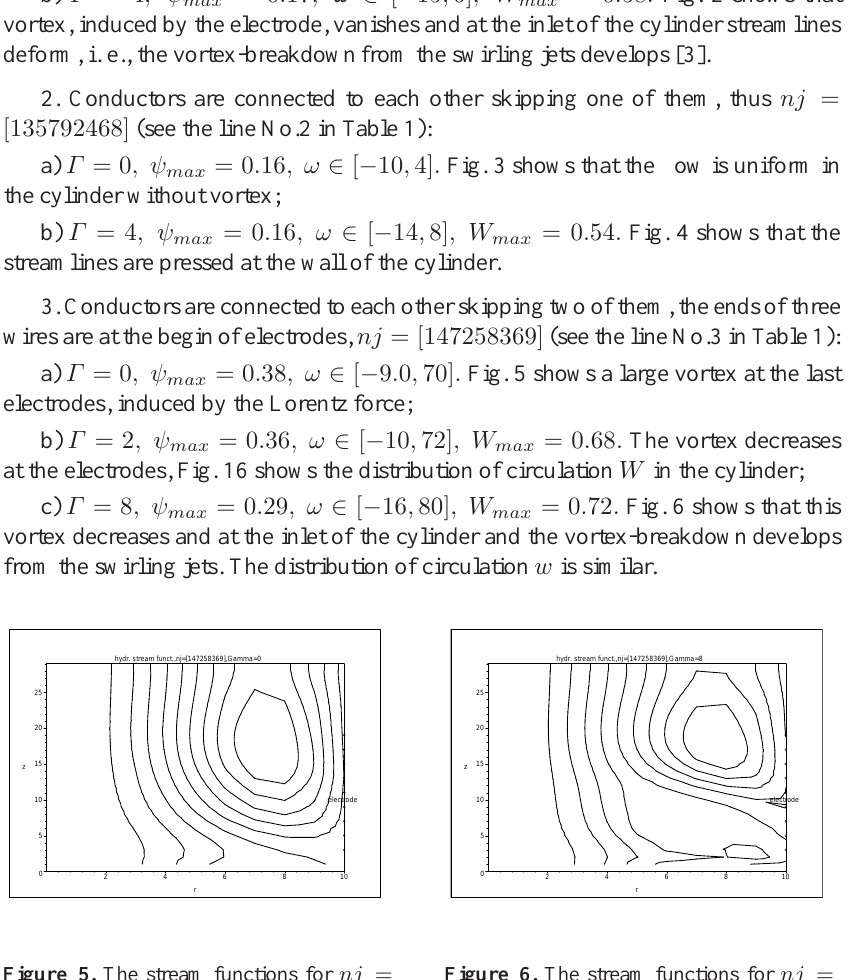
Figure 5. The stream functions for nj = [147258369] , ψ ∈ (0 . 00 , 0 . 38) , Γ = 0 .